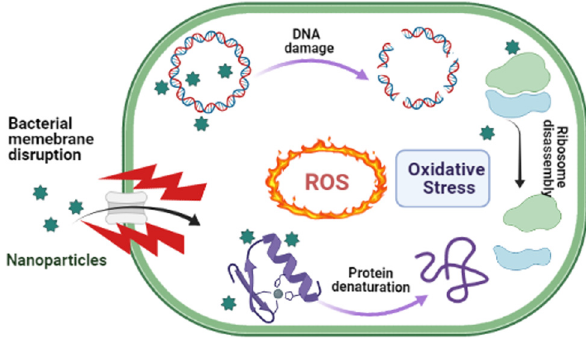
Figure 14: General mechanisms for antimicrobial action of